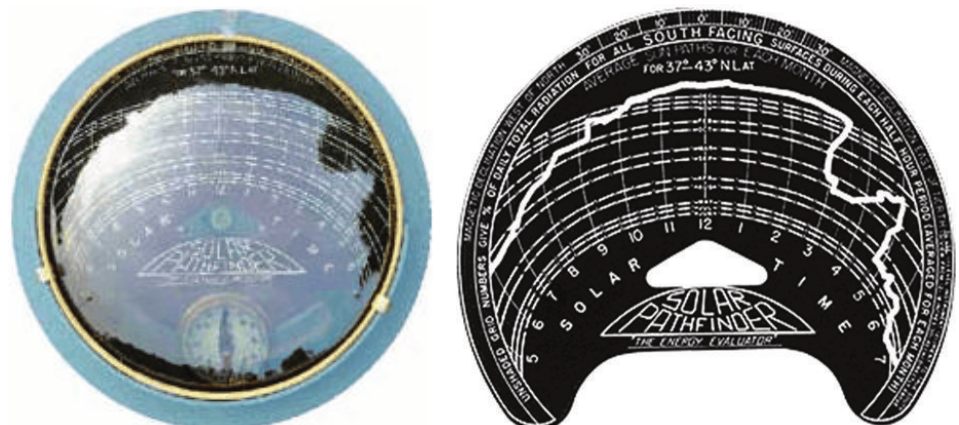
Figure 1: A typical solar path finder device (photo courtesy of Solar Pathfinder).